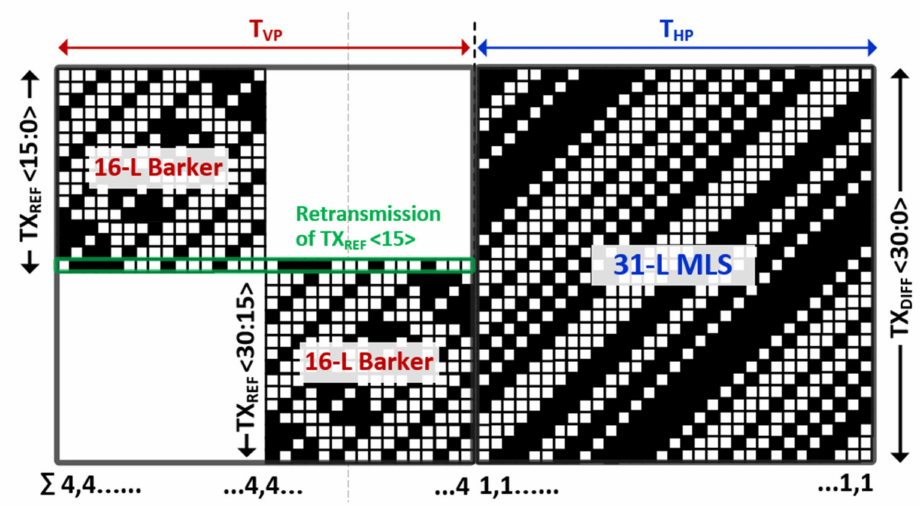
Figure 5. Application of different orthogonal sequences in reference and differential capacitance sensing. During T HP , all TX electrodes are driven simultaneously by the 31-L MLSs, which is desirable for two reasons. First, display noise due to the RGB pixel updates in the T HP does not saturate the AFE since the code summation is reduced to one mutual capacitance unit (C M ). Second, the SNR increases by the square root of 31 compared with that of sequential driving. Although the TX frequency is restricted to be much lower than the f TBW_UPPER and crosstalk exists between the TX electrodes, this noise penalty can be suppressed by permitting differential capacitance